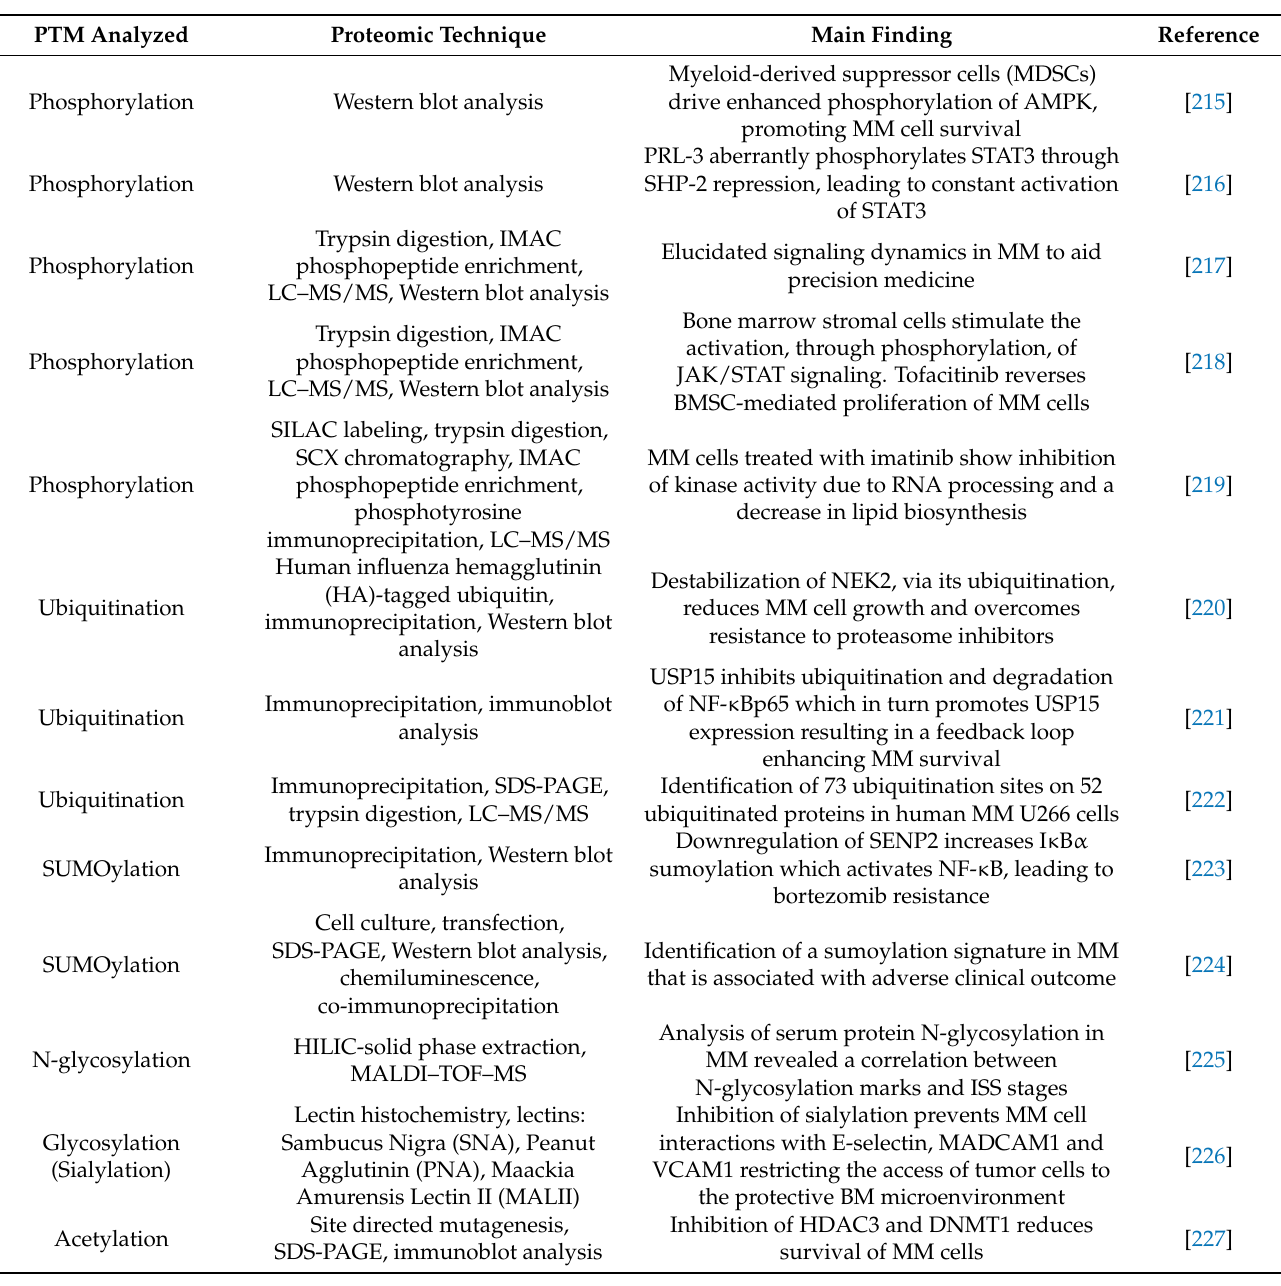
Table 2. Recent studies utilizing proteomic techniques to analyze PTMs in multiple